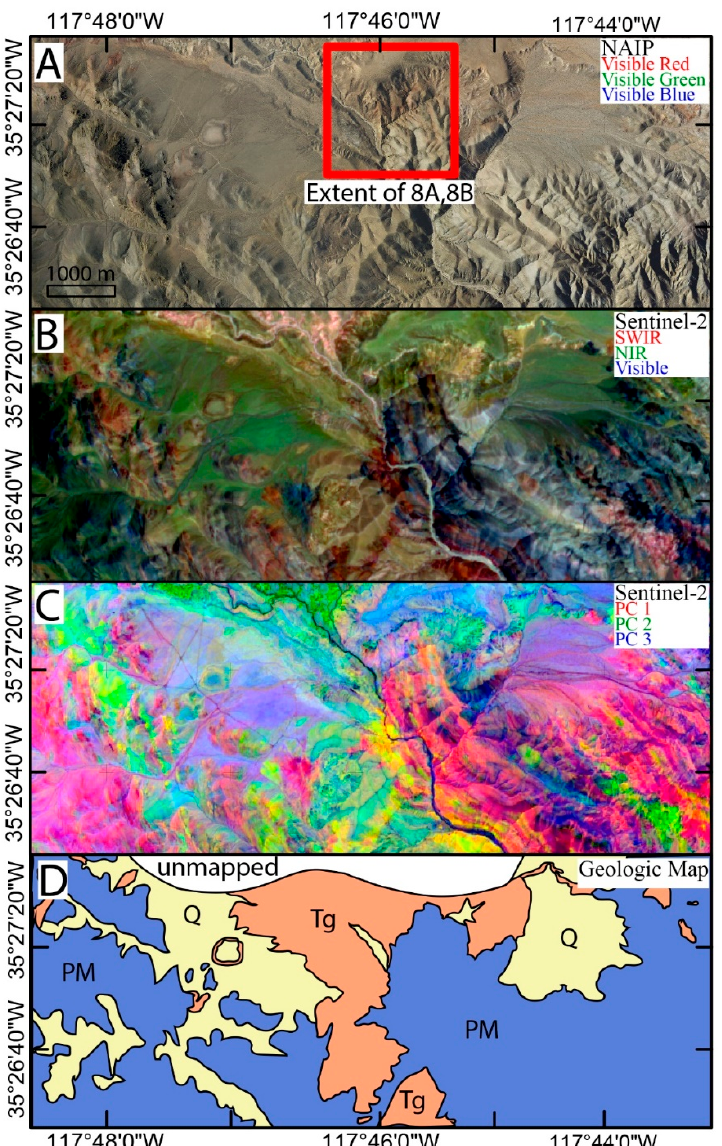
Figure 7. Characterization of the Goler study area. NAIP imagery ( A ) imagery contains useful spatial detail, which is complemented by Sentinel-2 SWIR / NIR / Visible false color composite ( B ) and low-order Principal Component ( C ) images. ( D ): Geologic map after [56]. In perhaps the clearest example of the three study sites, spatially coherent patterns evident in the false color composite reflectance and principal component images both match the overall patterns in, and add considerable richness to, the information present in the geologic map.